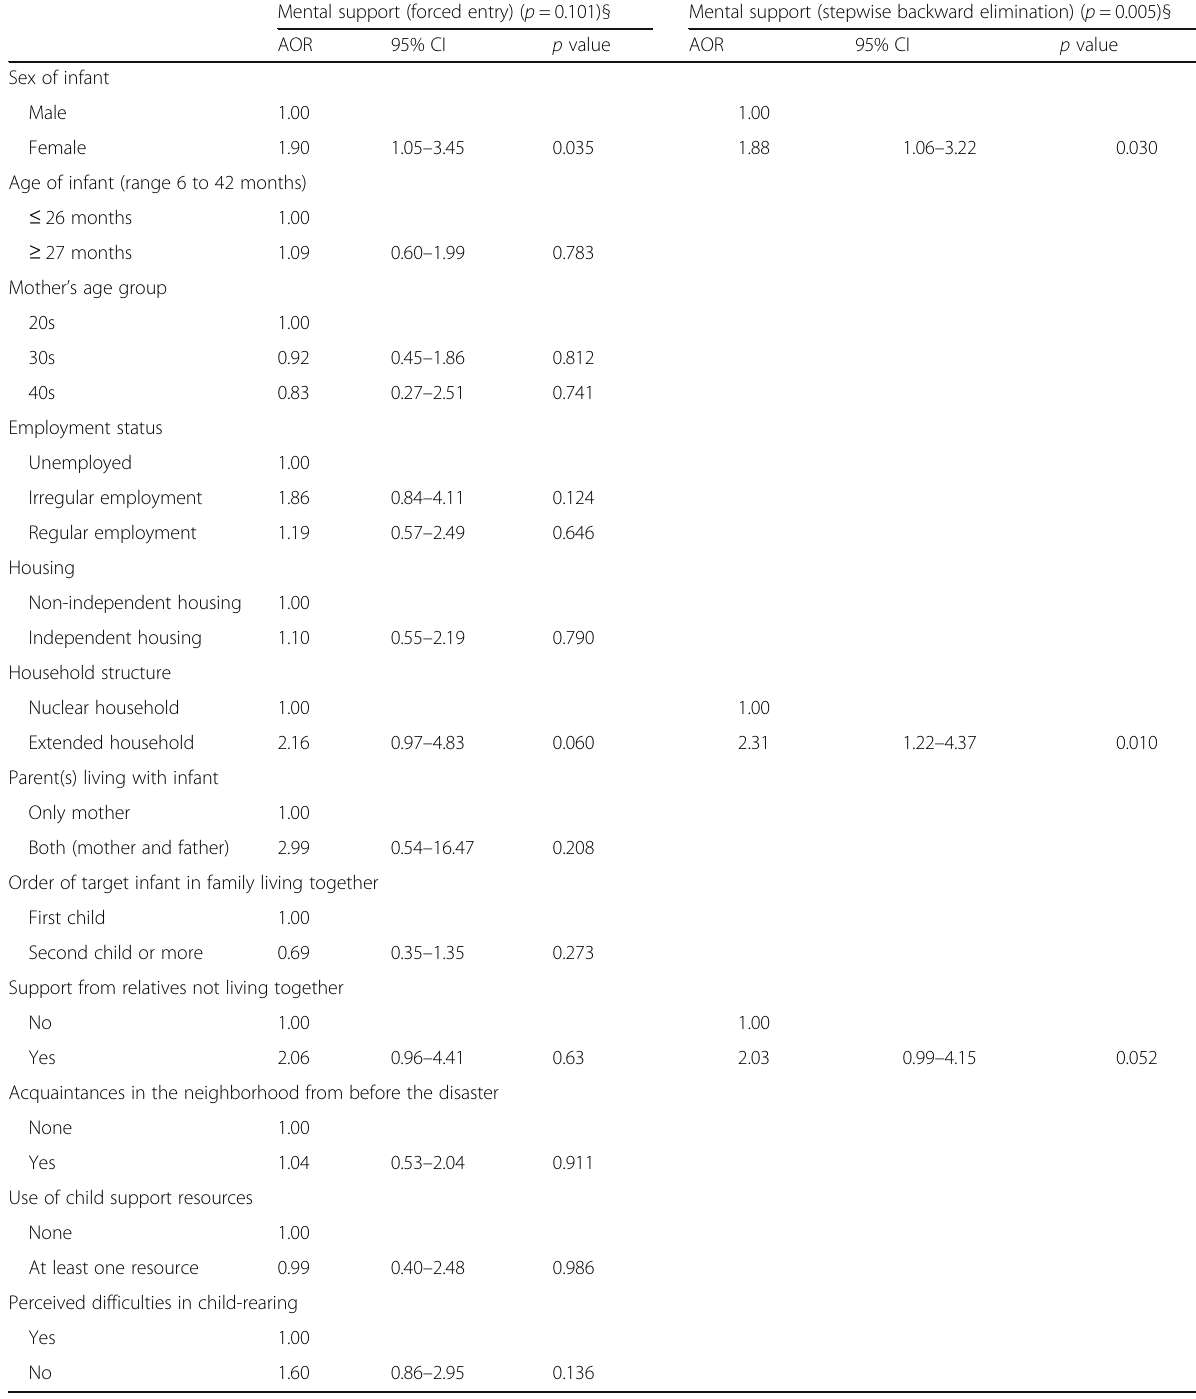
Table 3 Factors related to the obtainment of social support by mental support category ( n = 215) Mental support (forced entry) ( p =